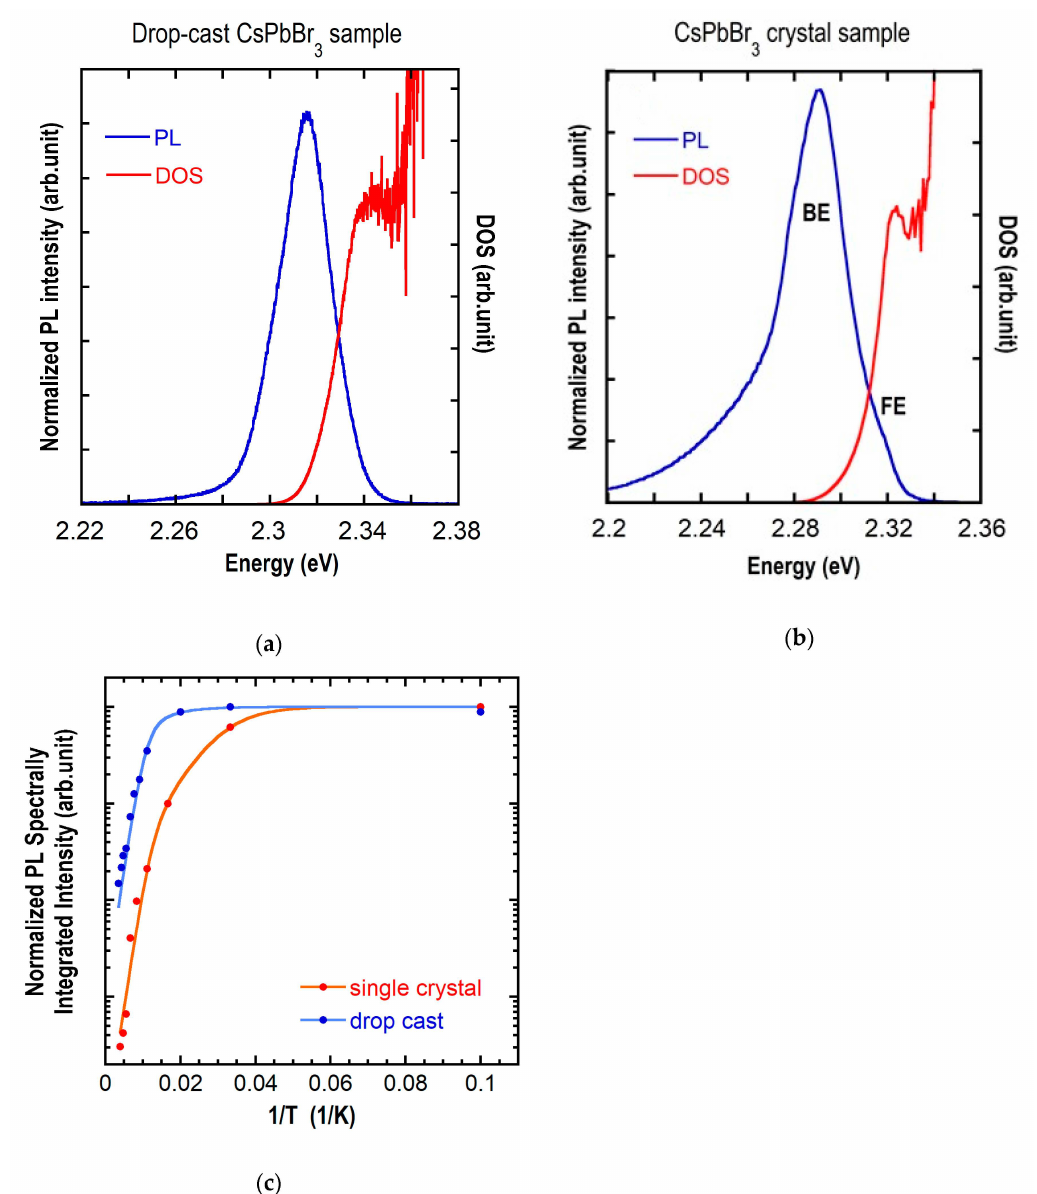
Figure 2. PL spectra of CsPbBr 3 ( a ) drop-cast and ( b ) single-crystal samples at 10 K. The red curves are the joint density of states (DOS) as extracted from the PL spectra according to [16]. BE and FE indicate the bound and free exciton emission, respectively; ( c ) Normalized spectrally integrated intensity of the PL (log scale) as a function of the inverse of the temperature is shown for CsPbBr 3 single-crystal and drop-cast samples (red and blue dots, respectively) along with the corresponding fitting curves (orange and light blue curves,